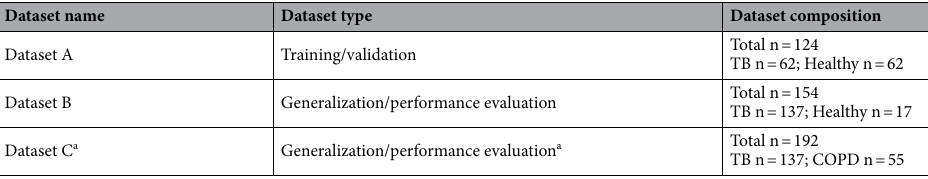
Table 1. MILO training/initial validation dataset and generalization datasets. Training was conducted on Dataset A only (TB and Healthy patients), no COPD cases were used in training. The TB cases (n = 137) are shared between Datasets B and C for validation, however these cases are distinct from the cases in Dataset A (n = 62). a The models were trained on TB and Healthy patient data only. No COPD cases were used in the training phase of these